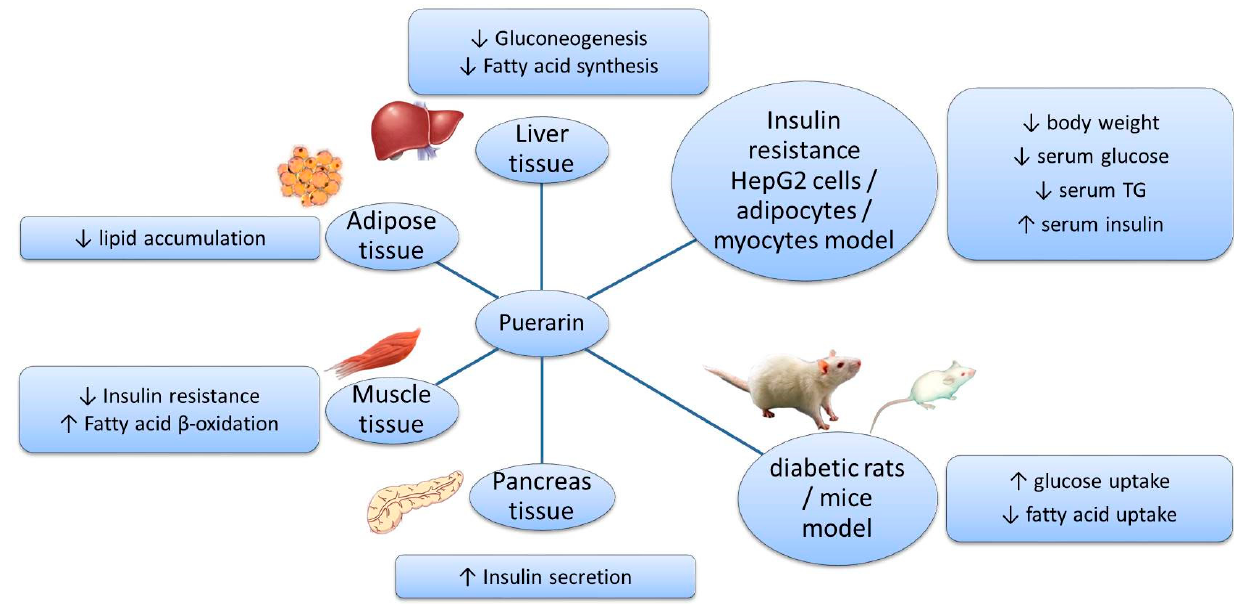
Figure 3. Effects of puerarin in different models and tissues.